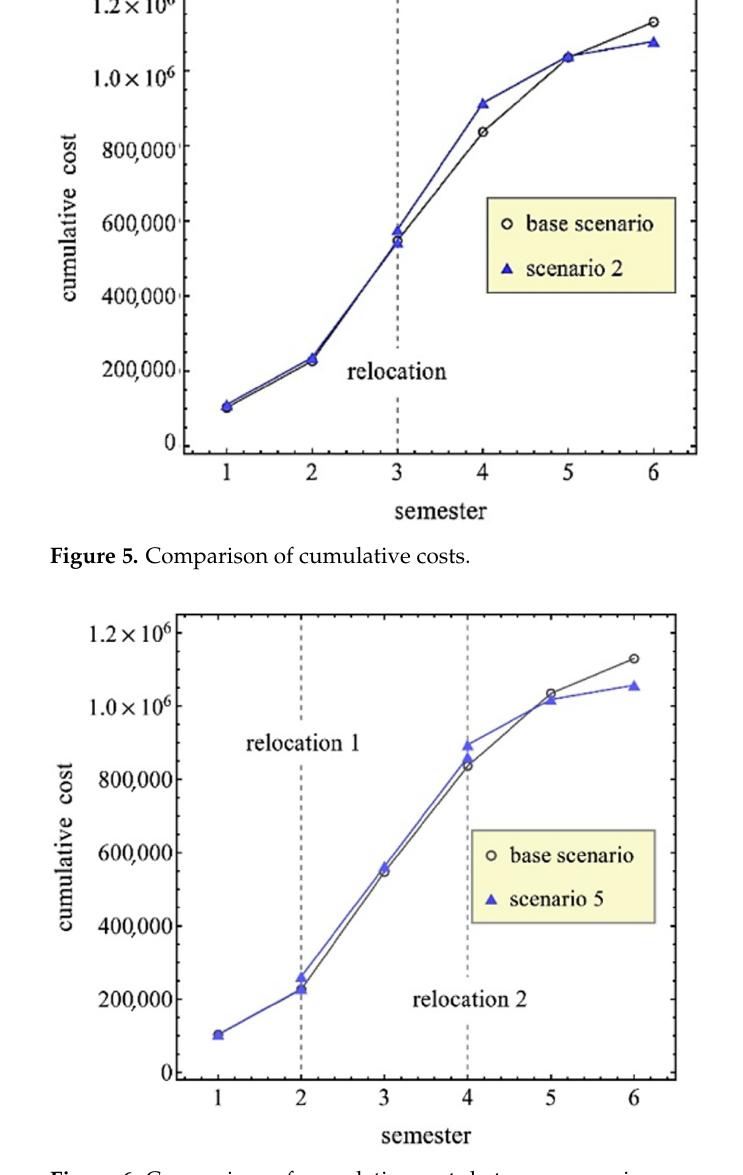
Figure 6. Comparison of cumulative costs between scenarios.